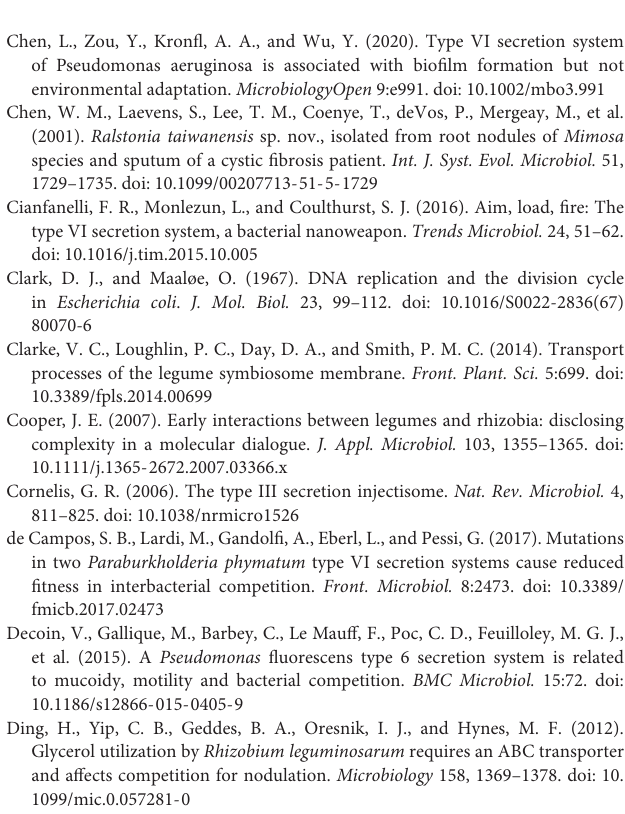
Supplementary Figure 1 | Alignment of all C4-dicarboxylate transporter found in P. phymatum which are similar to Bphy_5990 compared with other C4-dicarboxylate transporter from Yurgel and Kahn (2004). Glutamate transporter family proteins show eight conserved domains and four conserved motifs. Motif A is the most conserved motif and is hypothesized to correspond to the substrate-binding site. Supplementary Figure 2 | (A) The maximum likelihood phylogenetic tree of T6SS-3 was constructed as described in methods based on the DNA sequences of the identified clusters. The reference sequence accession numbers of the NCBI database is shown in brackets and the bootstrap values are shown left of the respective branches. The bar at the bottom left indicates the distance. (B) Comparison of the gene arrangement of the two T6SS-3 clusters in P. phymatum STM815 and B. pseudomallei K96243. NC_006351 from the NCBI database, visualized with CLC Genomics Workbench 11.0. Supplementary Figure 3 | Expression of P. phymatum wild-type GFP reporter constructs (pPROBE, p5978, p6115, and p6116) in nodules of Phaseolus vulgaris . The pPROBE was used as negative controls. Images were taken with a confocal laser scanning microscope (DM5500Q; Leica). LUT Fire was used to color-code the expression. Supplementary Figure 4 | Root attachment assay with wild-type and T6SS mutants. No significant difference in the root attachment ability was observed between the strains. Three independent experiments were performed with nine biological replicates per strain ( n = 9). A one way-ANOVA showed no significant difference between the strains. Error bars indicate the standard